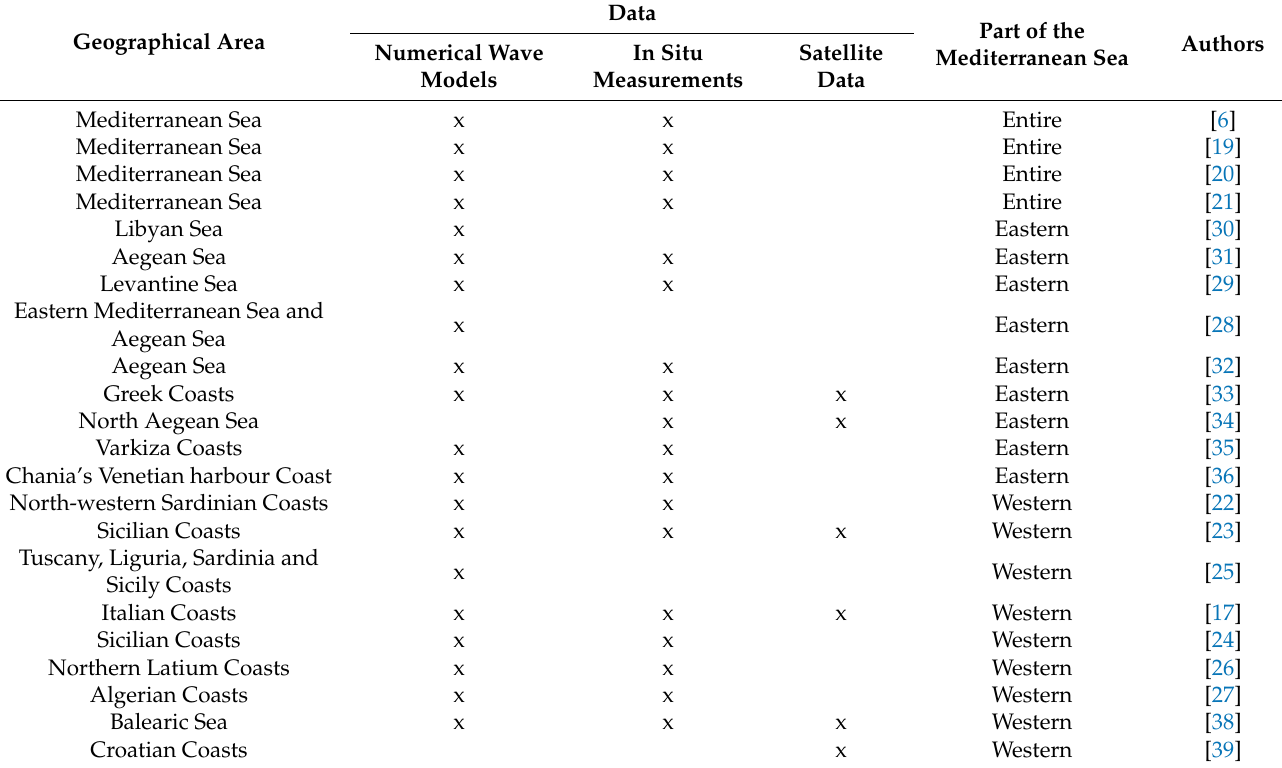
Table 1. Wave energy resource assessment studies in the Mediterranean Sea and type of examined data.